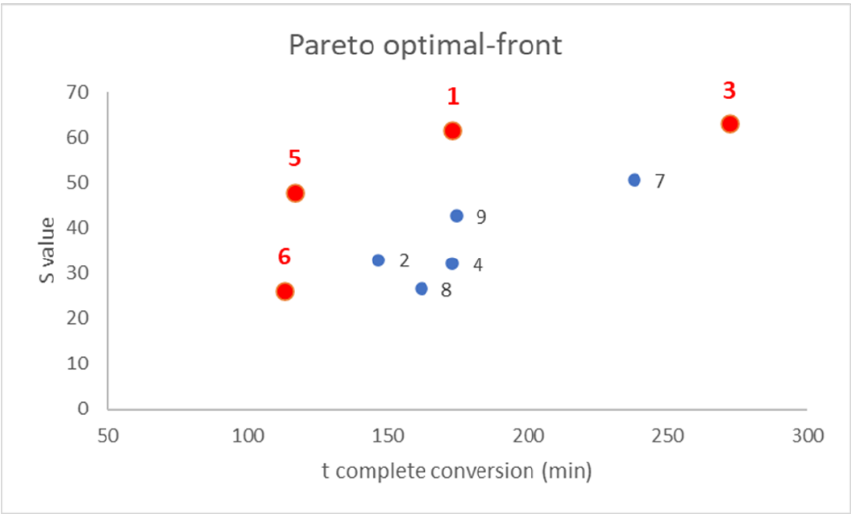
Figure 5. Pareto optimal-front reporting the two responses, time required for complete conversion ( x -axis) and S value ( y -axis) for the prepared sensors, labeled from 1 to 9 as reported in Table S1.